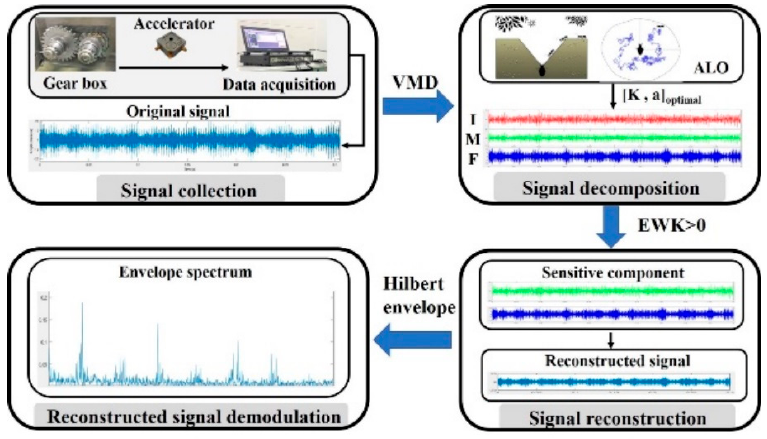
Figure 18. The framework of the feature extraction method.